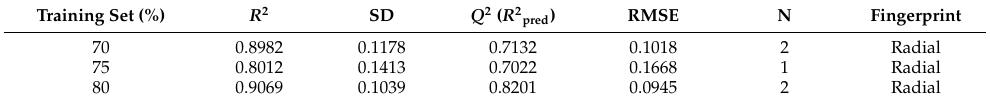
Table 2. Statistically significant models generated by AutoQSAR for the G 1